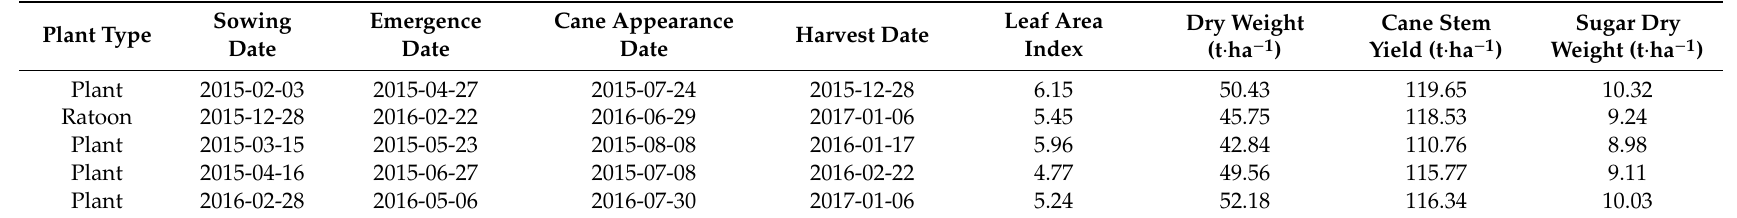
Table 2. Growth parameters measured at the sugarcane field experiment from 2015 to 2017.